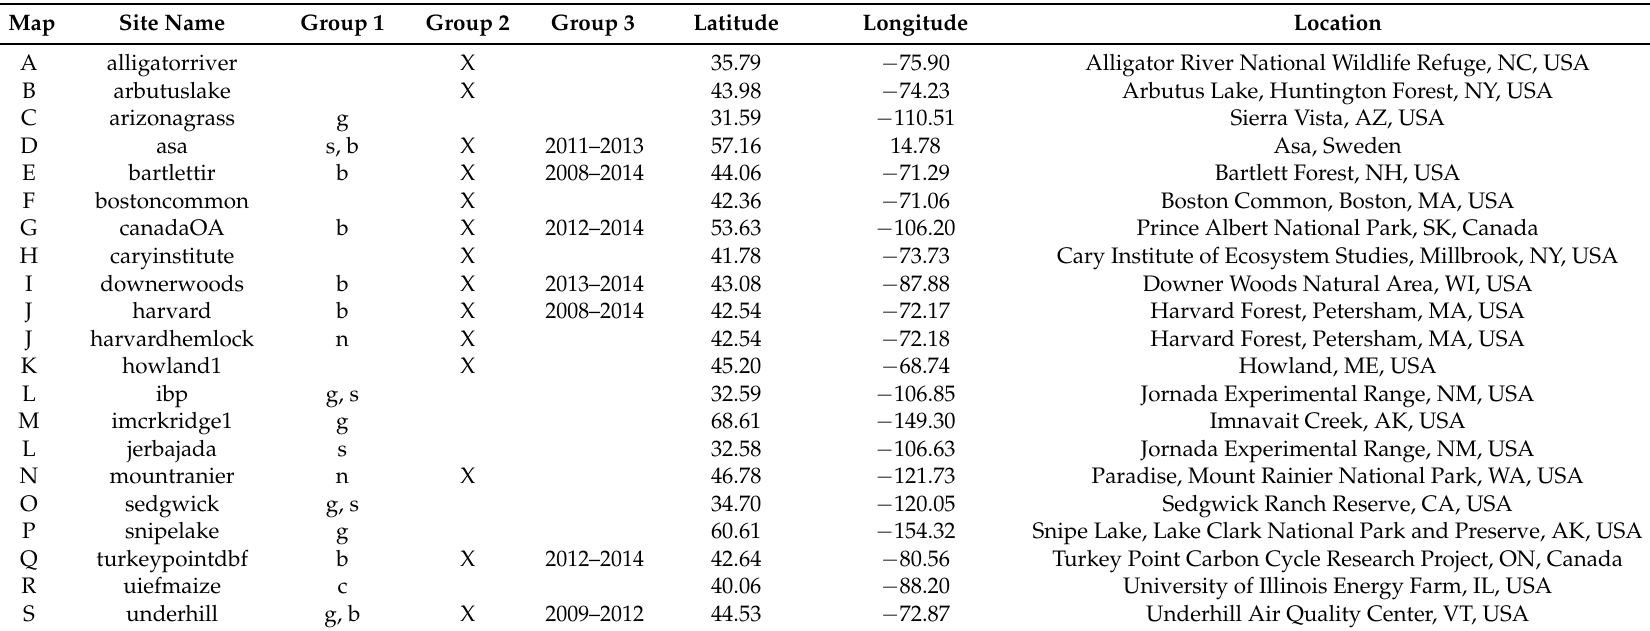
Table 1. PhenoCam sites used in Season Spotter and subsequently